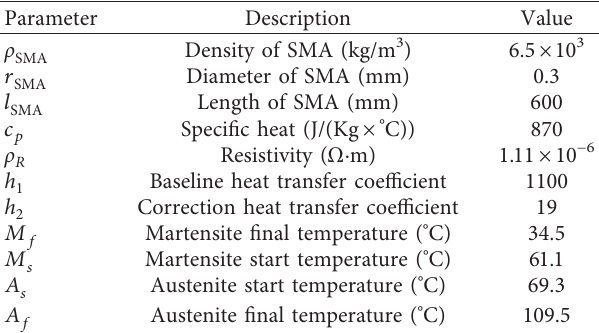
Table 1: Performance parameters of SMA